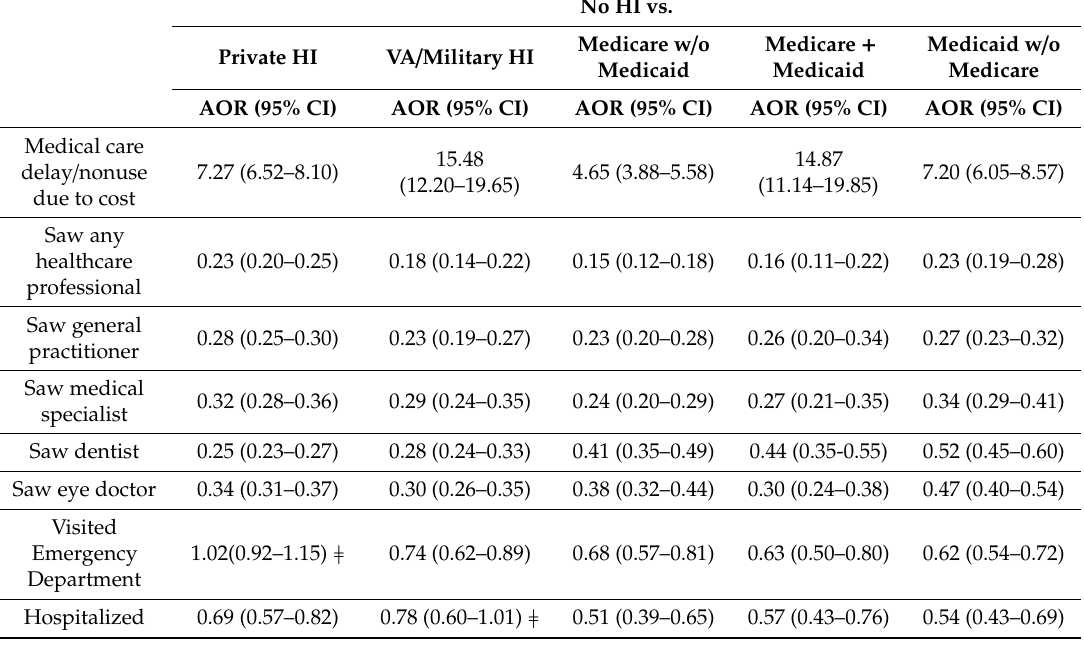
Table 5. Past year healthcare access among those without any health insurance (HI) compared to those with di ff erent types of HI among the 50–64 age group: Results from binary logistic regression models. No HI